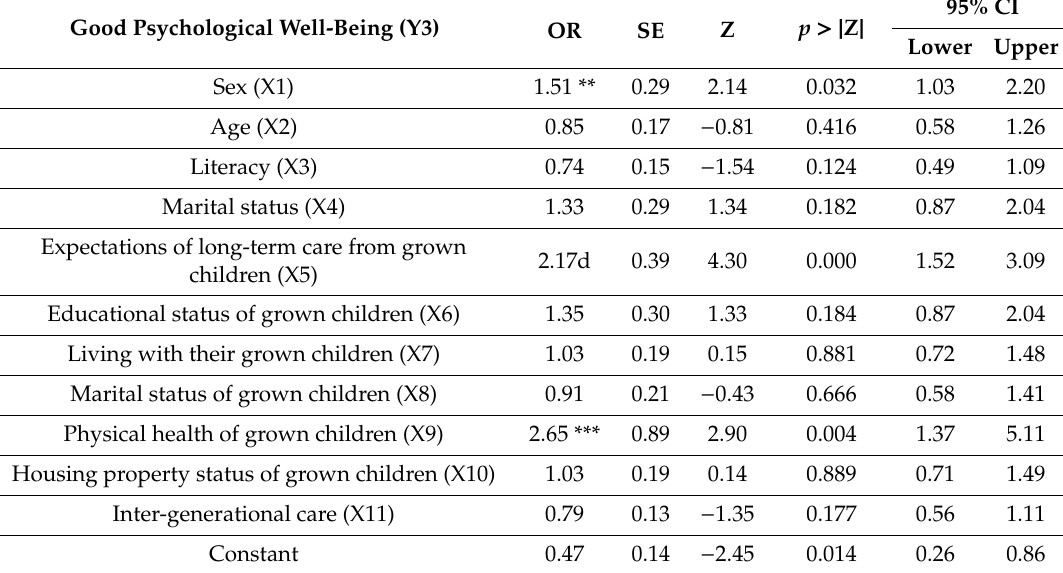
Table 7. Logistic regression results on good psychological well-being.